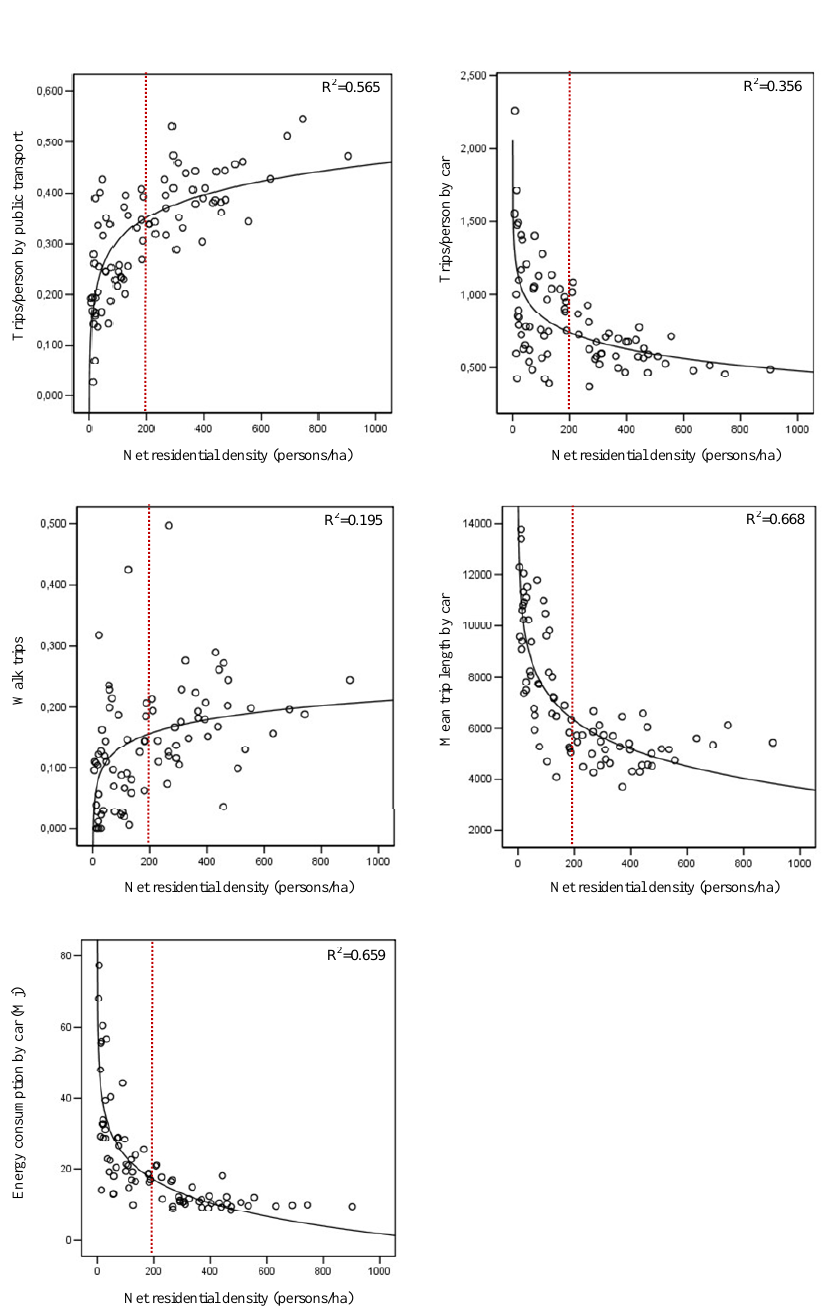
Figure 2. Graphical representation of the relationship between density and travel